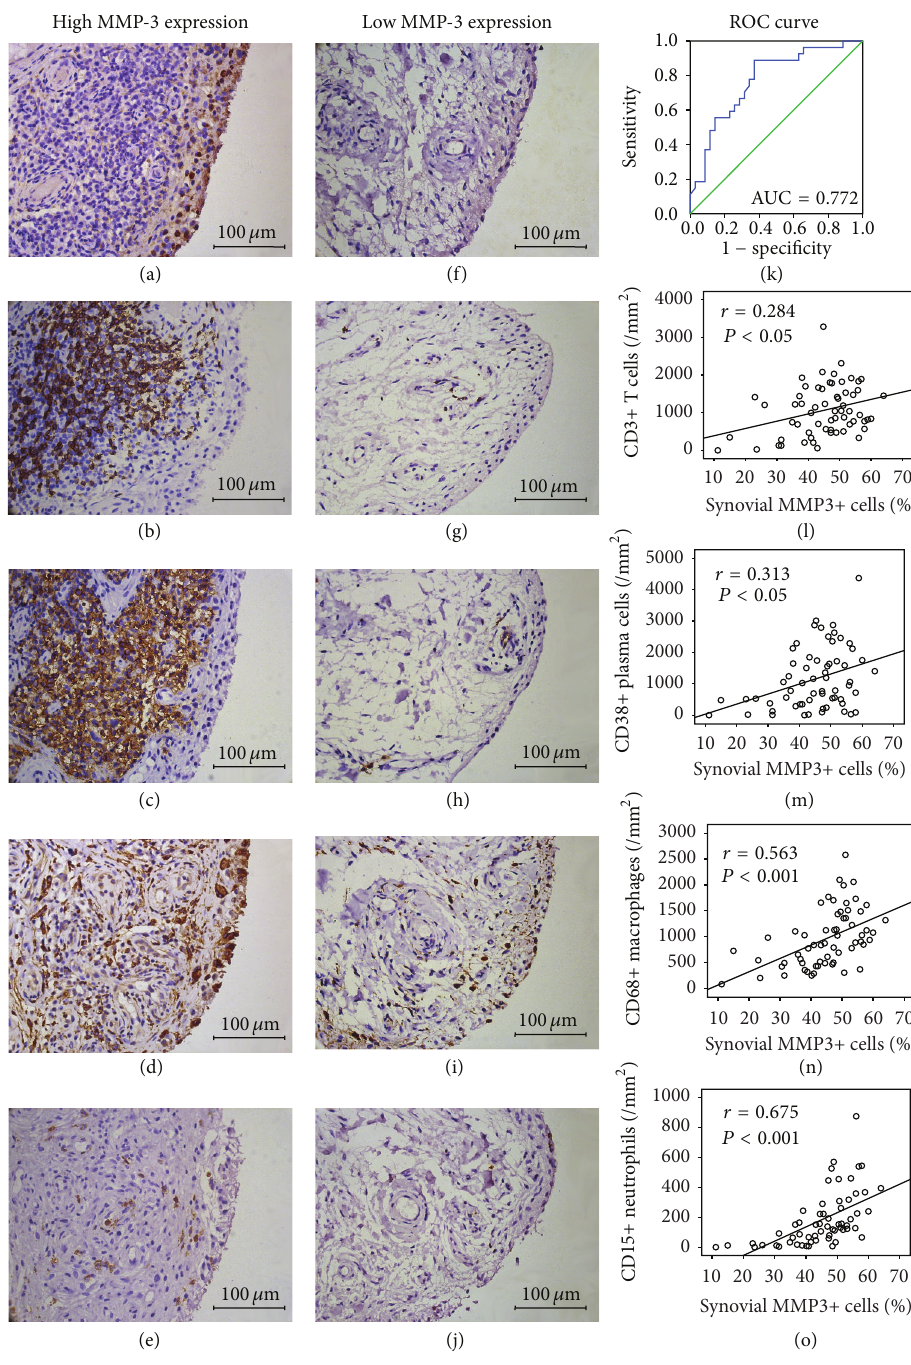
Figure 4: (a ∼ j) Synovial MMP-3 expression and inflammatory cells in representative synovium from 2 different patients with RA. High and low MMP-3 expression in the endochylema of lining cells in RA synovium (a and f). Case one showed aggregated CD3+ T cells (b) and CD38+ plasma cells (c), together with diffuse infiltration of CD68+ macrophages (d) and CD15+ neutrophils (e). Case two showed a small number of CD3+ T cells (g), CD38+ plasma cells (h), CD68+ macrophages (i), and CD15+ neutrophils (j). In panels (a) to (j), immunohistochemical stains with DAB as chromogen (brown); original magnification × 400. (k) ROC curve showed synovial MMP-3 with the ability to distinguish high grade fromlow grade synovitis. (l ∼ o)Spearman’s rank correlation analysis between synovial MMP-3 and CD3+ Tcells (l), CD38+ plasma cells (m), CD68+ macrophages (n), and CD15+ neutrophils